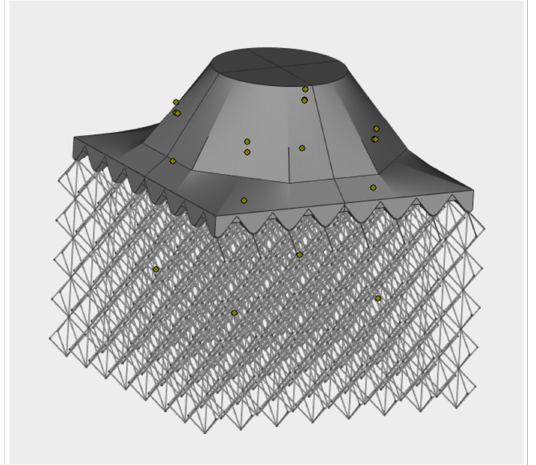
Figure 12. Design proposal circular machine connection with cones as the load introduction feature— example for the f2ccz lattice—isometric